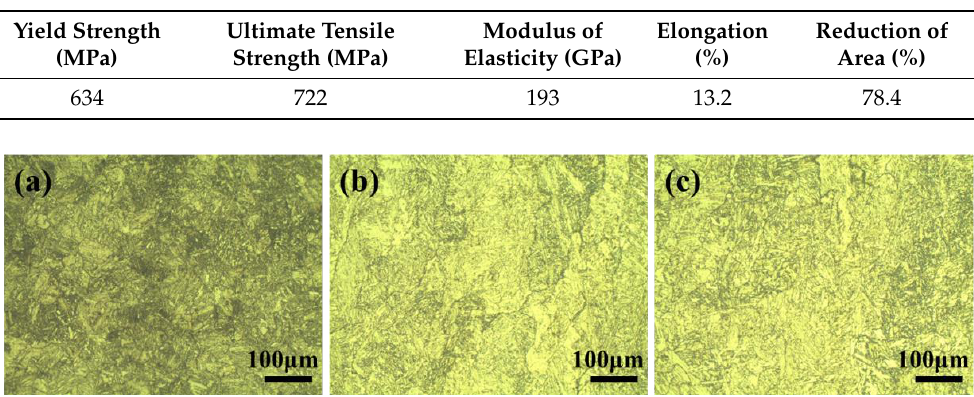
Table 2. Chemical composition of BM (wt%). Table 3. Mechanical properties of the welded joint.